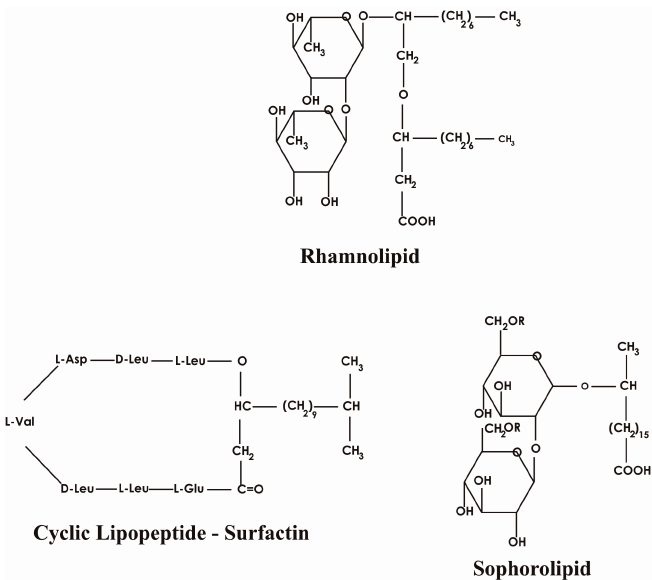
Figure 3. Major chemical types of biosurfactants produced by